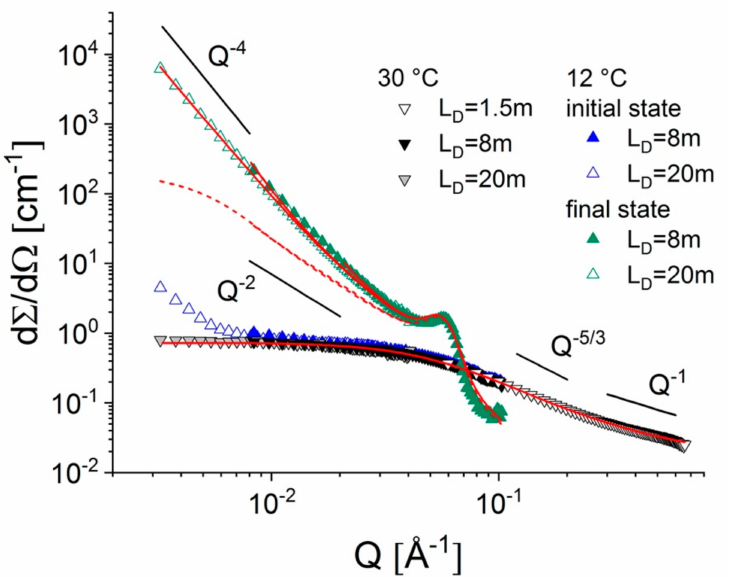
Figure 6. SANS cross sections from solution of hPEGDME (M W = 20,000 g mol − 1 ) in dTHF ( φ pol = 2%) measured at different temperatures, during the FTIR analysis (Figure 7). Data collected at different L D and temperatures are differentiated by symbols and colors as shown in the legend. The solid lines indicate the power law behavior in different Q ranges, whereas the red curves represent the model description of the experimental data, as discussed in the text. The dotted curve represents the scattering pattern from the lamellar stacks, as resulted from the global fit of the experimental data collected in the final state at 12 ◦ C (green